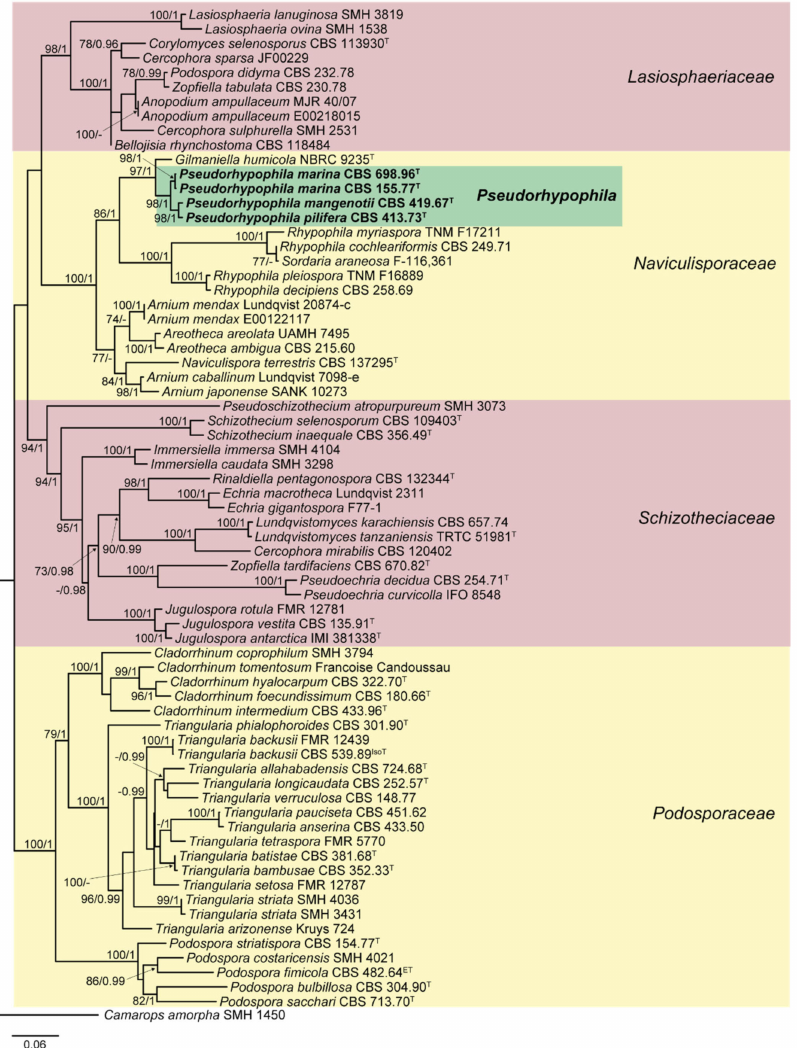
Figure 1. Randomized axelerated maximum likelihood (RAxML) phylogram obtained from the combined sequences of the internal transcribed spacer region (ITS), the nuclear rDNA large subunit (LSU), and fragments of ribosomal polymerase II subunit 2 ( rpb2 ) and β -tubulin ( tub2 ) genes of selected strains belonging to the families Lasiosphaeriaceae, Naviculisporaceae, Podosporaceae, and Schizotheciaceae, using Camarops amorpha SMH 1450 as outgroup. Bootstrap support values ≥ 70 / Bayesian posterior probability scores ≥ 0.95 are indicated along branches. Branch lengths are proportional to distance. Novel taxa proposed in the present study are in bold . Ex-epitype, ex- isotype, and ex-type strains of the different species are indicated with ET , IsoT , and T , respectively. Different background colors have been used to highlight the major